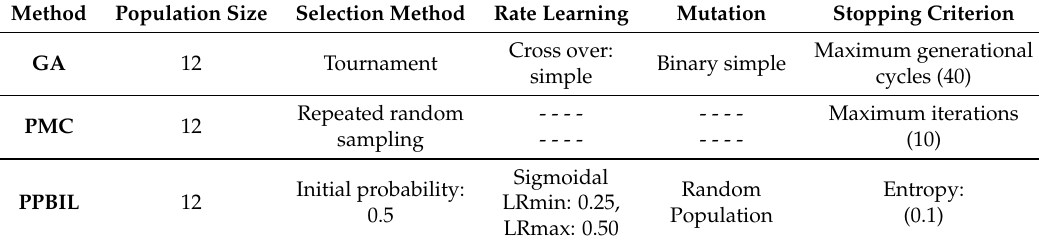
Table 1. Parameters of location techniques.